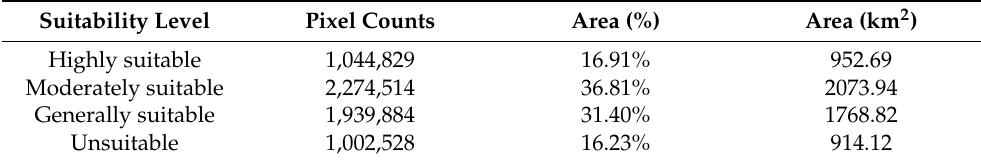
Figure 6. Tea cultivation suitability classes in the study area. Table 7. Potential land area in each suitability class.